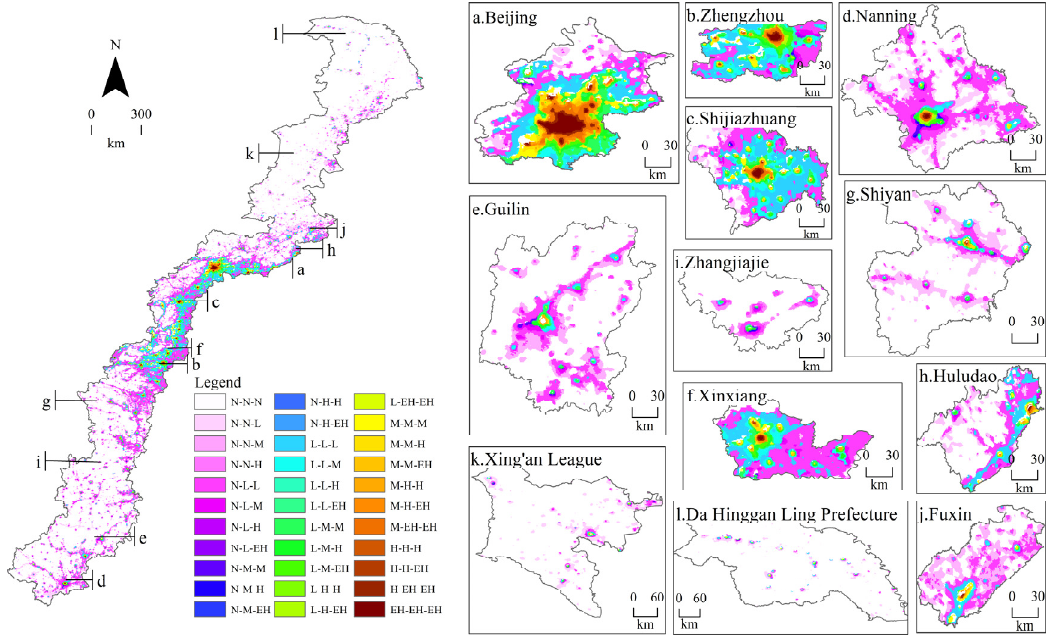
Figure 11. Spatiotemporal transitions of different nighttime lighting types in the whole region and different tier cities between 1984, 2002, and 2020.